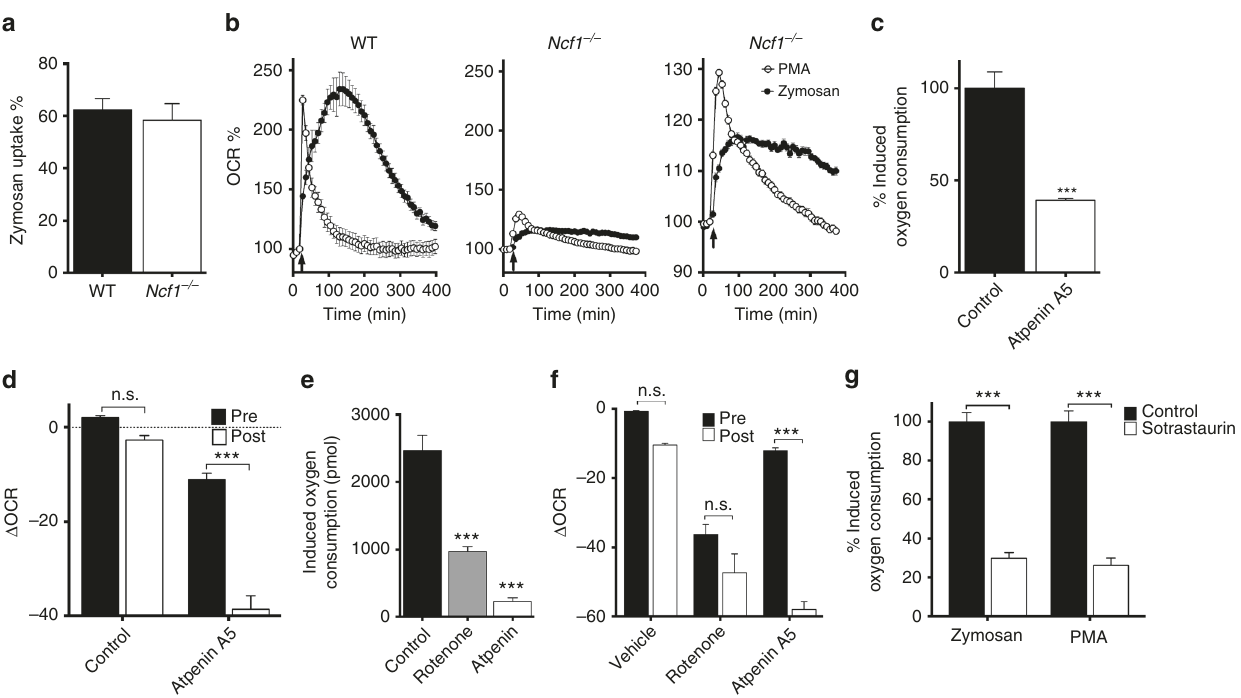
Fig. 7 The metabolic enhancement in peritoneal tissue-resident macrophages occurs independently of NOX2, but can be initiated with activation of protein kinase C. a Peritoneal tissue-resident macrophage (pTRMØ) uptake of pHrodo zymosan (50 μ g/ml) from Ncf1 − / − and WT mice. Data show 3 separate wells per group and was not signi fi cantly different by Student ’ s t -test. b OCR changes in WT and Ncf1 − / − pTRMØ after addition of zymosan or phorbol – myristate – acetate (PMA, 1 μ M) at the indicated arrow. The far-right line graph shows an expanded view of Ncf1 − / − data from the middle plot. Data from the WT show n = 3 separate wells per group from one experiment, whereas the Ncf1 − / − shows n = 5 per group from two separate experiments. Both are representative of at least three independent experiments. c The relative total oxygen consumption after addition of atpenin A5 or vehicle control in Ncf1 − / − pTRMØ. Data ( n = 5 separate wells per group) represent two independent experiments and were analysed by Student ’ s t -test. d Graph showing change in OCR after addition of atpenin A5 or vehicle control. Post treatment (Post) is applied 90 min after zymosan addition, pre-treatment occurs before, in the absence of zymosan (Pre). Data ( n = 10 – 12 separate wells per group) were pooled from two independent experiments and were analysed by two- way ANOVA (interaction p < 0.0001) with Sidak ’ s post-tests. e Quanti fi cation of the total oxygen consumption after addition of PMA in the presence of the indicated inhibitors (rotenone = 200 nM). Data ( n = 3 – 6 separate wells per group) represent two independent experiments and were analysed by one- way ANOVA ( p < 0.0001) with Tukey ’ s post-tests. f Graph showing change in OCR after addition of the indicated drugs. Post treatment (Post) is applied 40 min after PMA addition, pre-treatment occurs before, in the absence of PMA (Pre). Data ( n = 5 – 6 separate wells per group) represent two independent experiments. Data were analysed by two-way ANOVA (interaction p < 0.0001) with indicated Sidak ’ s post-tests. g The protein kinase C inhibitor relative total oxygen consumed post burst stimulants. Data ( n = 5 separate wells per group) represent two independent experiments, analysed by